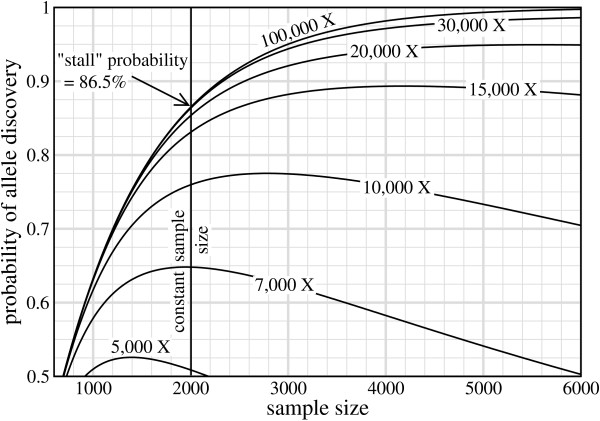
Gibbs' scenario [17]of using a fixed 2,000 unit sample size to discover extremely rare alleles, ϕ = 0.0005, under N = 1 and τ = 2. This hypothetical project is plotted for 5,000 ≤ R ≤ 100,000 and shows the conspicuous "stalling" effect that occurs under increasingly non-optimal conditions.